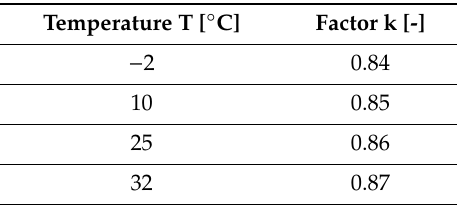
Table 8. List of conversion factor "k"